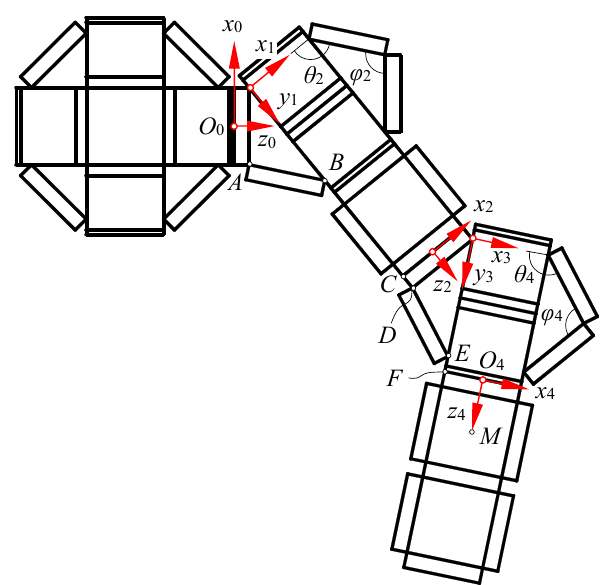
Figure 5. Geometry and coordinate systems of the robotic